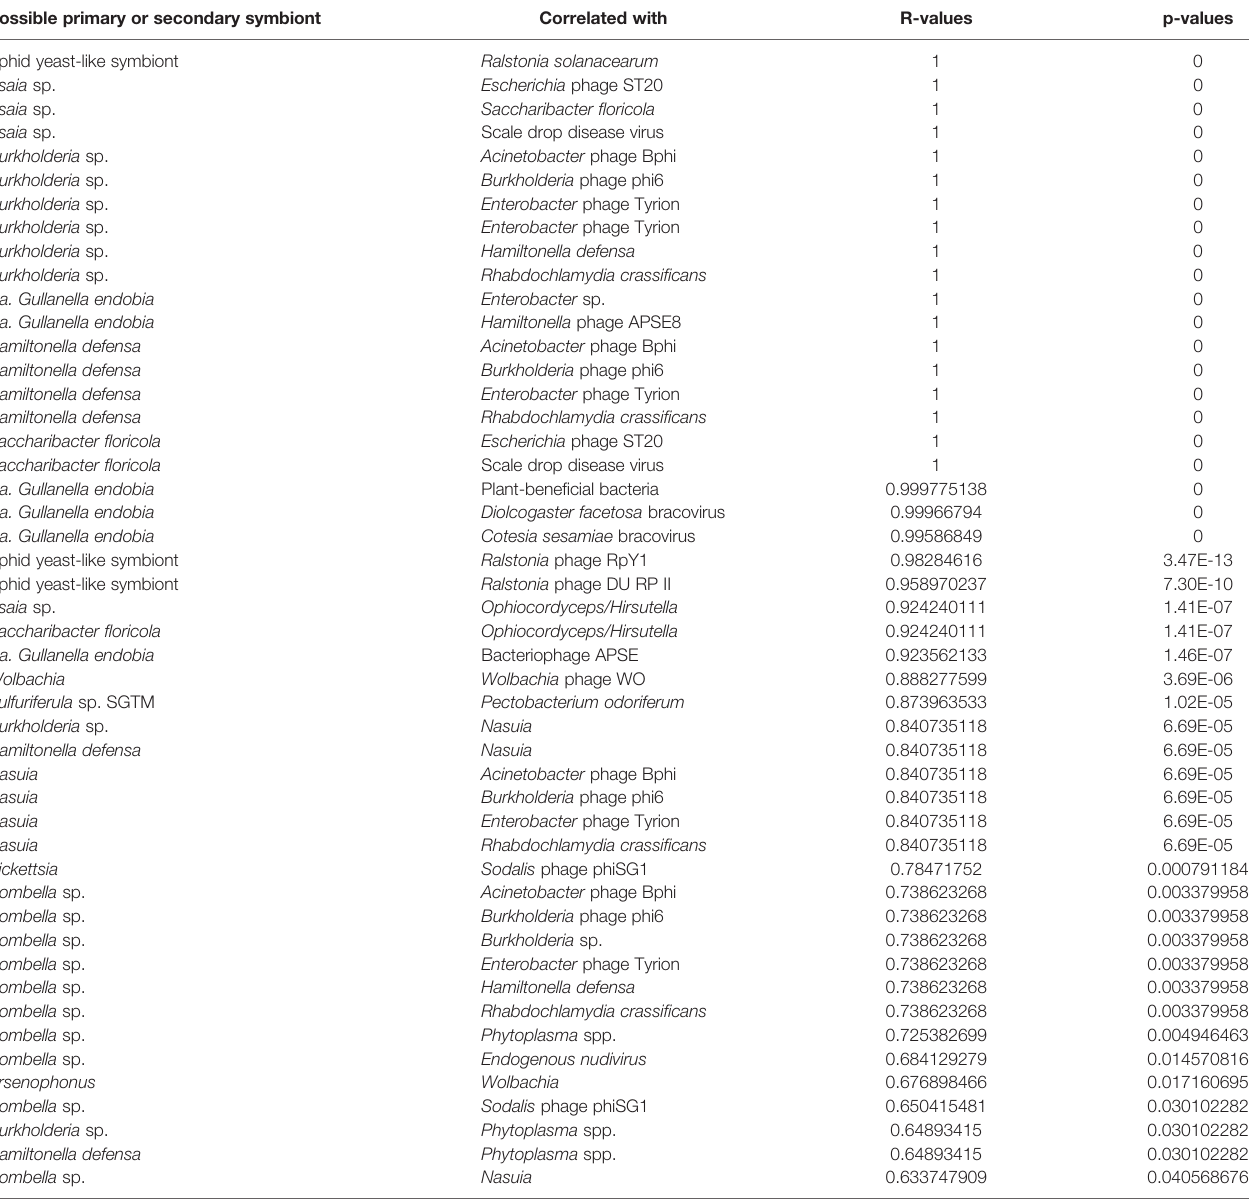
TABLE 3 | Statistically signi fi cant correlations between relative abundances of primary and secondary symbionts of membracids and other organisms and viruses in the